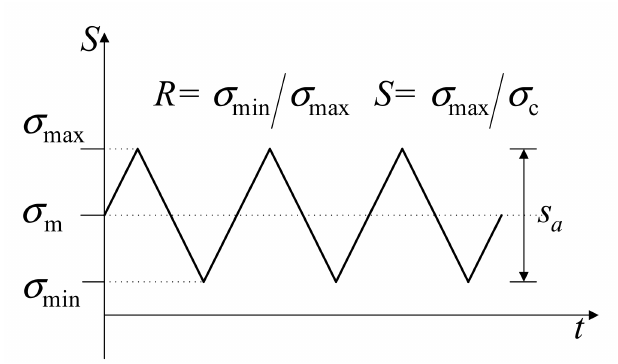
Figure 3. Fatigue loading